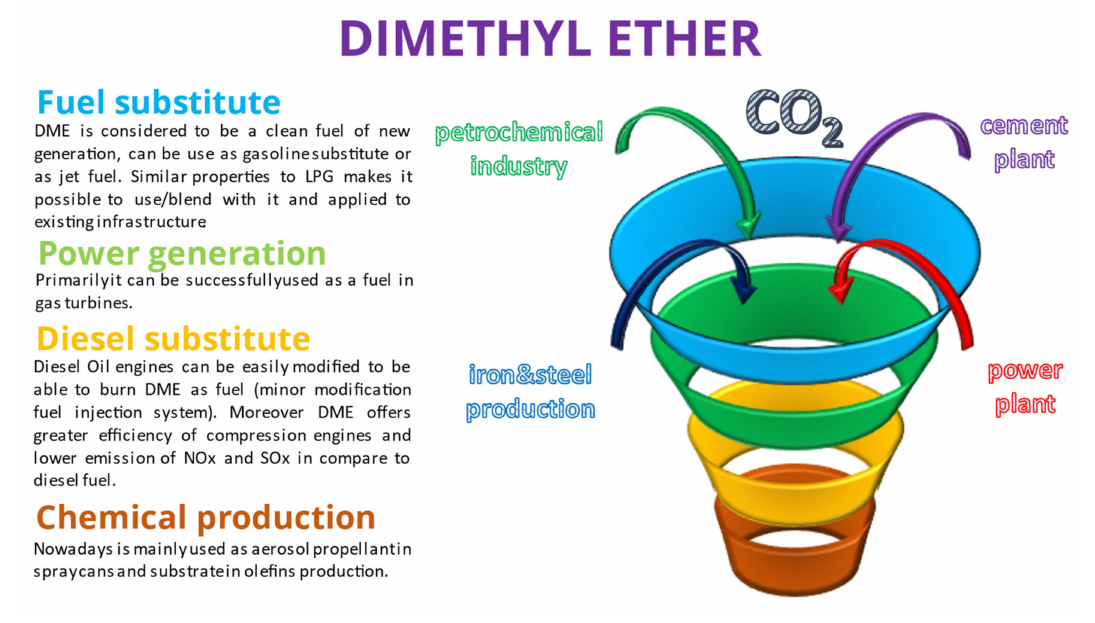
Figure 1. Applications of DME [20,24].